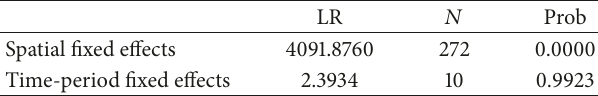
Table 5: Joint significance test of spatial and time-period fixed